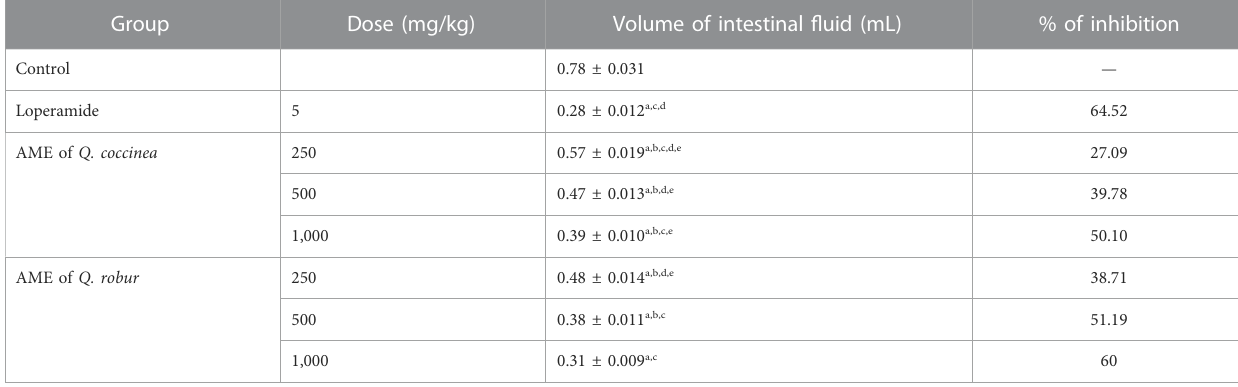
TABLE 5 Effects of Q. coccinea and Q. robur on gastrointestinal motility in mice. Group Dose Length of small (mg/kg) intestine (cm)